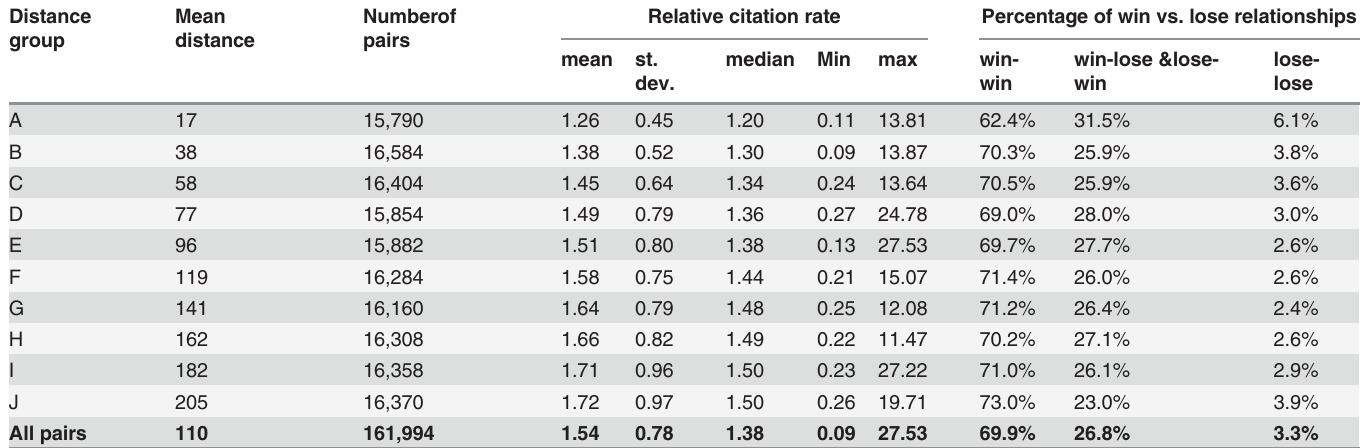
Table 2. Distance categories of subdiscipline pairs (A-J) with mean distance and number of pairs, mean, standard deviation, median, minimum and maximum of relative citation rate and the percentage of win-win, win-lose/lose-win and lose-lose relationships per group. Distance group